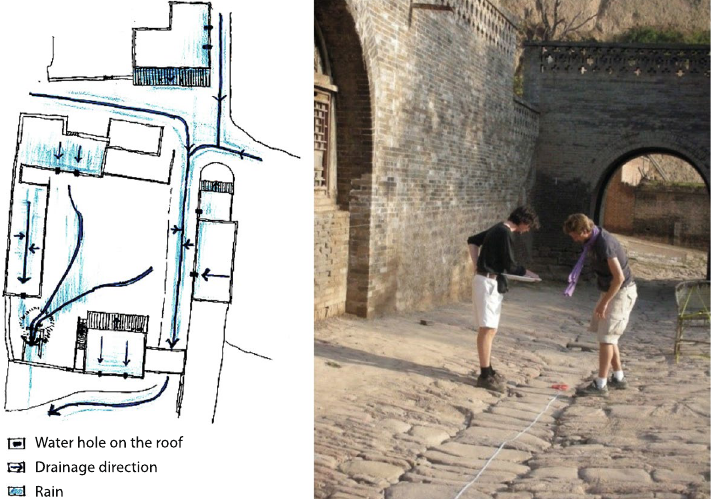
Fig. 11 Topographic microprocessing in the stage square and underground rainwater collection and drain systems (Source: Tongji University and Ecole de Chaillot